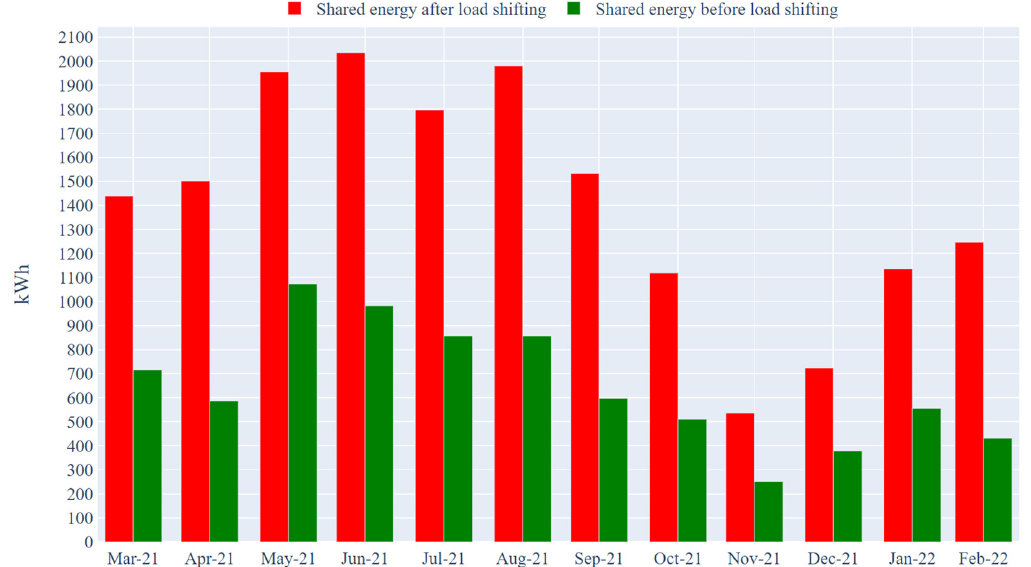
Figure 10. Shared energy comparison before and after the load shifting simulation.